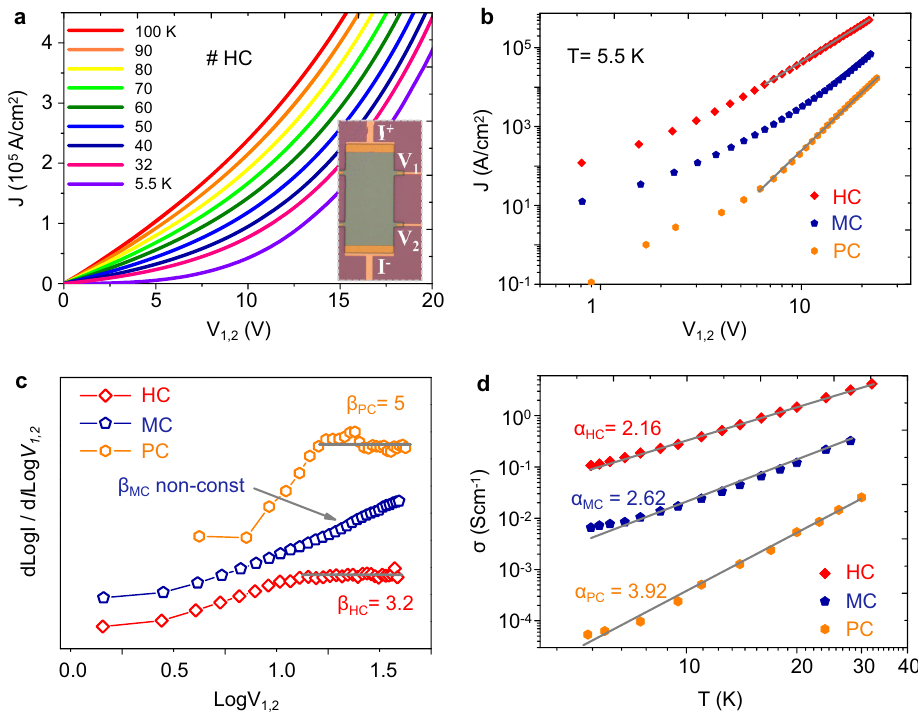
Fig. 2 Crystalline degree-dependent nonlinear transport behaviors. a Nonlinear I – V curves obtained in a HC sample at temperatures ranging from 5.5 to 100 K. The inset shows the photo of the measured device, I + and I − denote the current, and V 1,2 is obtained by the two voltage probes, V 1,2 = V 1 − V 2 . b Double logarithmic-scaled I – V curves for HC (red), MC (blue), and PC (orange) samples at T = 5.5 K; the gray line denotes the power-law I – V relation at high voltage in HC and PC samples. c Plot of the values of dLog I /dLog V 1,2 with respect to Log V 1,2 . The constant values of power-law exponents β are obtained in the HC and PC samples ( β PC = 5, β HC = 3.2) but not in the MC sample. d Double logarithmic-scaled conductivity-temperature ( G – T) relations for HC (red), MC (blue), and PC (orange) samples at temperatures ranging from T = 5.5 – 32 K. The gray line is power-law fi tting of the data, with the extracted exponents α for three samples. Values of α (2.16, 2.62, and 3.92) were extracted within the conductivity-temperature ( G = dI/dV ∝ T α )